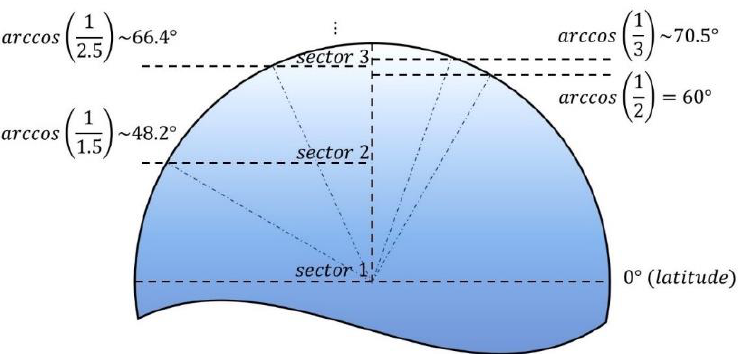
Figure 6. Northern hemisphere of the earth.